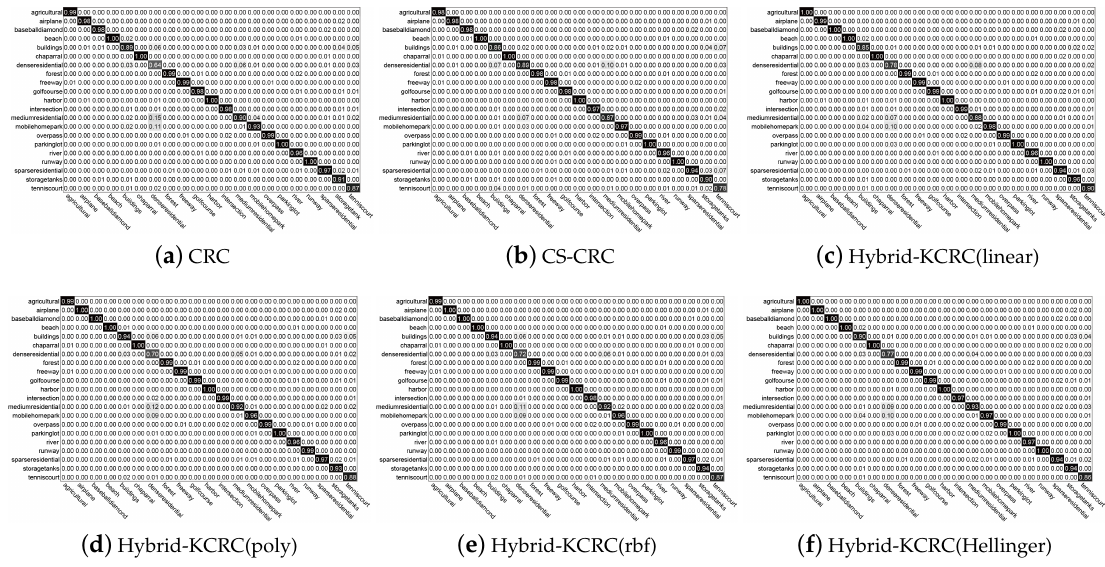
Figure 5. Confusion matrices on UC-Merced dataset.